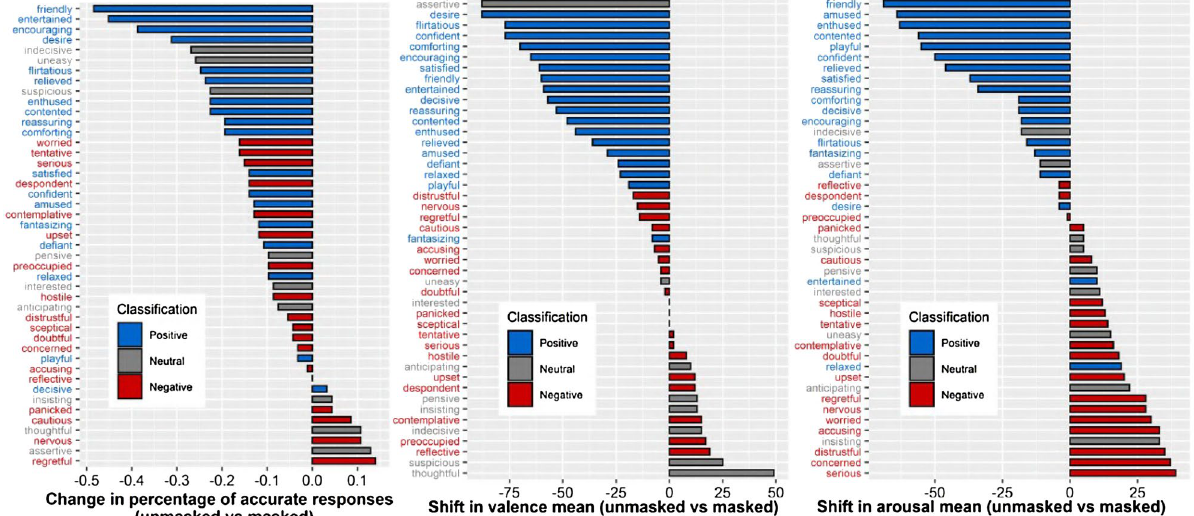
Figure 2. Changes in means of recognition accuracy, perceived valence and perceived arousal between the unmasked and the KN95 conditions for each mental state. Left: Masking impairs the recognition of most facial expressions. Middle: All the mental states previously classified as positive undergo a negative shift in valence. Right: Perceived arousal decreases for positive mental states but increases for negative mental